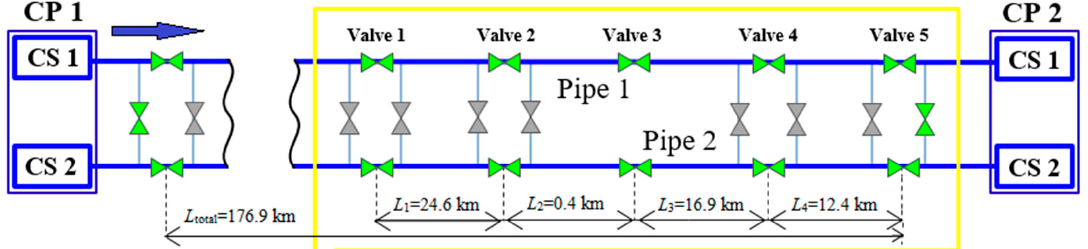
Figure 1. Interconnection diagram of two-pipe fragment of main pipeline.